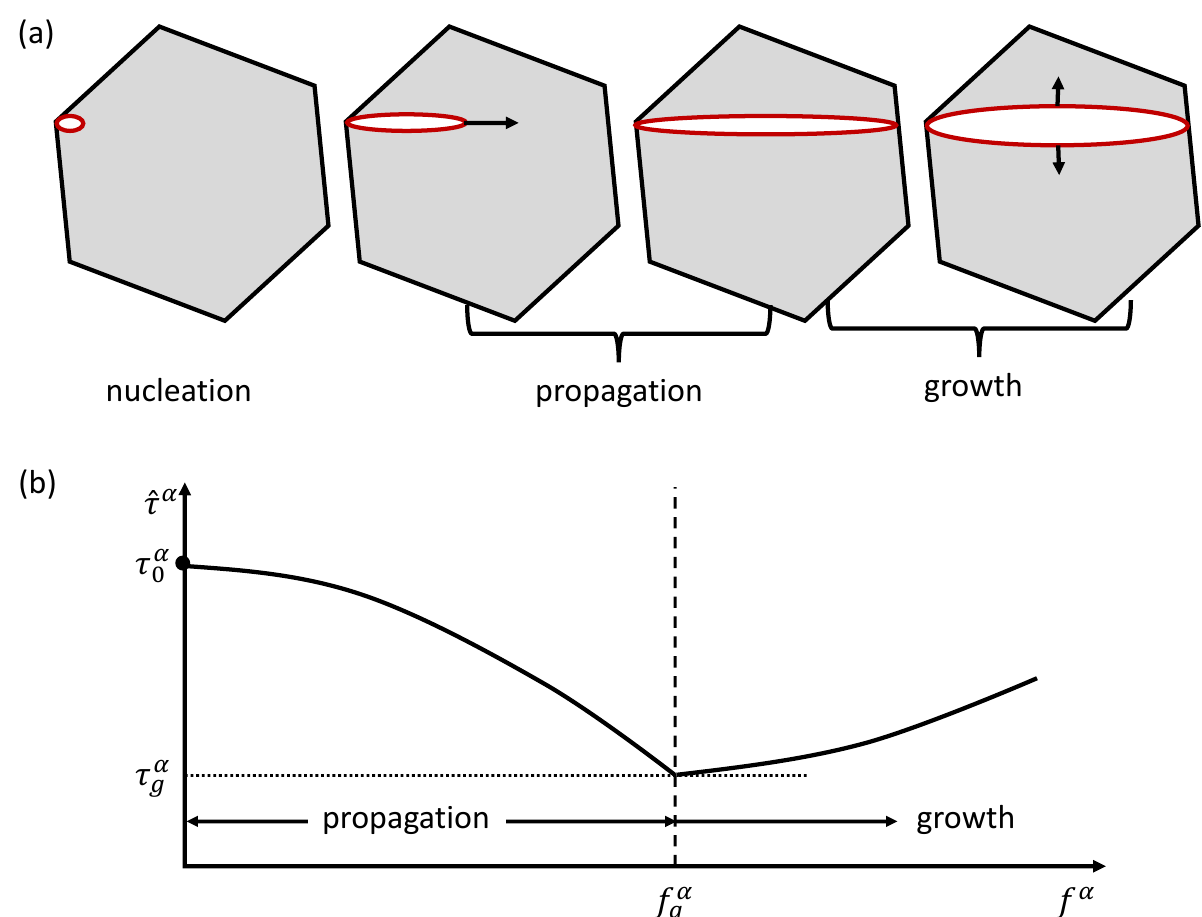
Figure 10. A schematic representing ( a ) the TNPG (CG) model within a grain and ( b ) resistances for twin nucleation, propagation, and growth. Data from